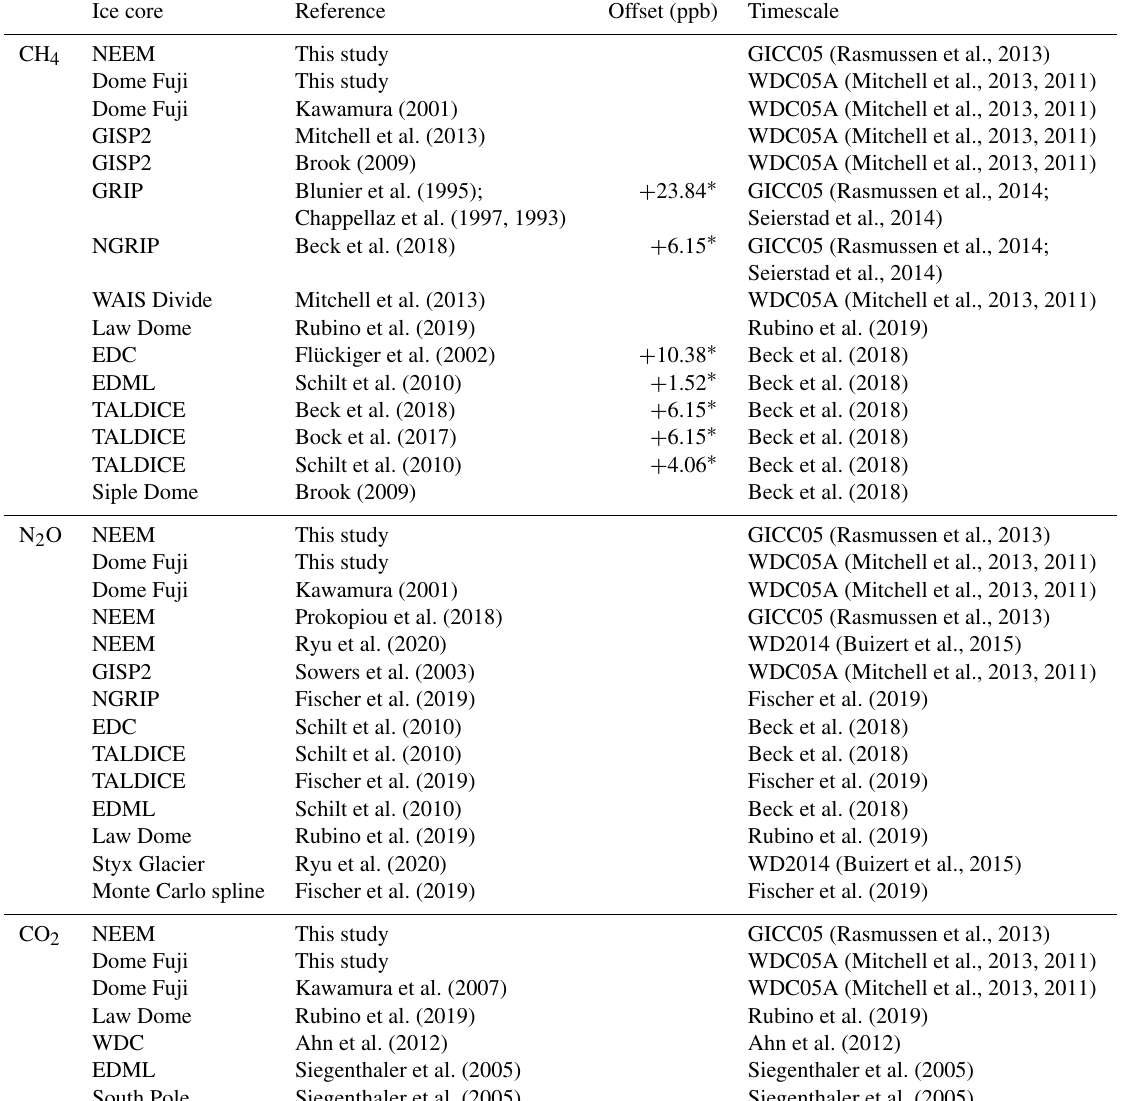
Table A1. Ice cores and timescales shown in this